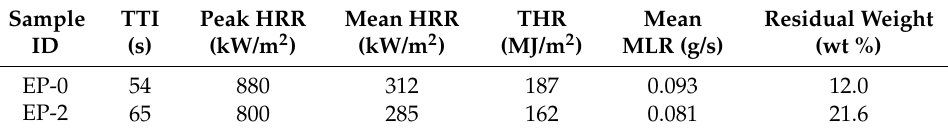
Table 2. Cone calorimeter data of EP-0 and EP-2.